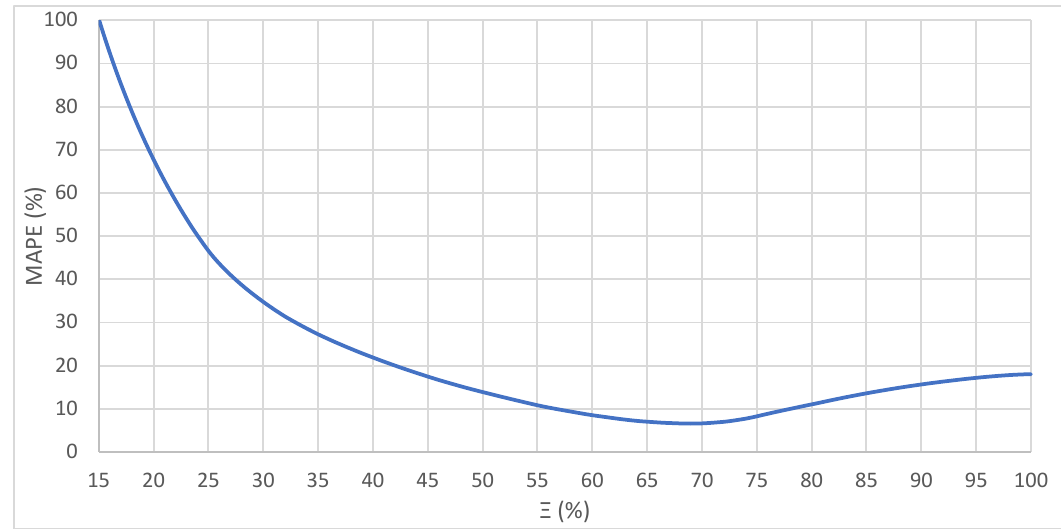
Figure 4. Equation (16) results for the whole range of the dimensionless inlet depth of the screw (Ξ) values in comparison with the currently installed AST designs of Table 2.